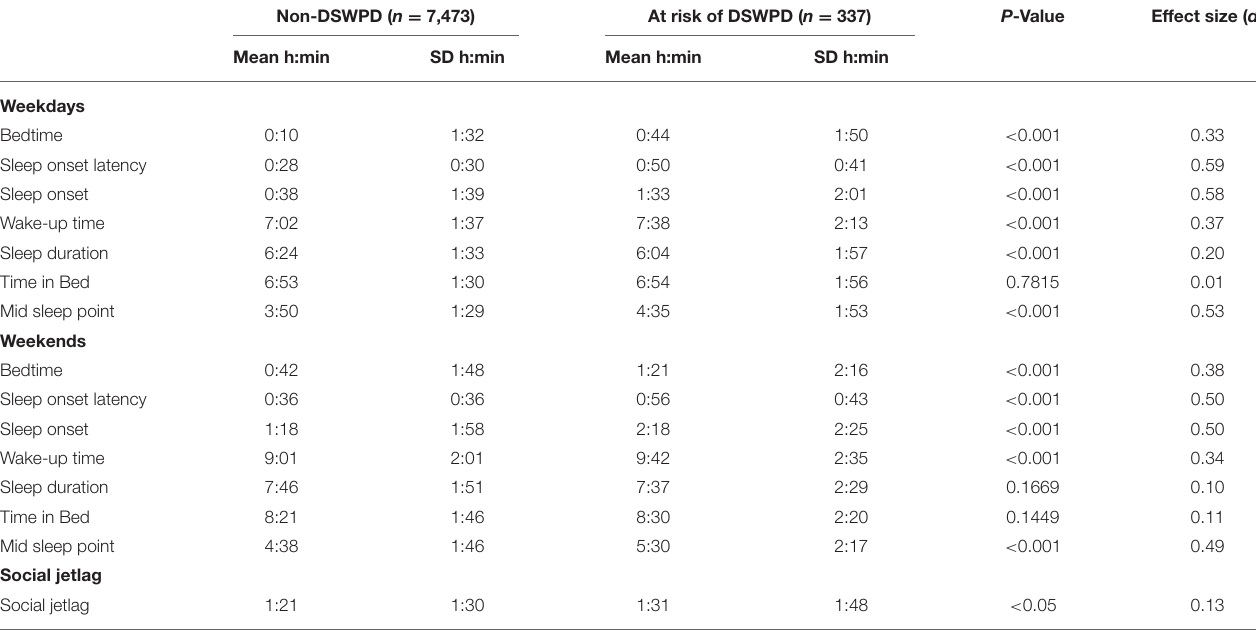
TABLE 2 | Sleep behaviors of the participants at risk of delayed sleep-wake phase disorder (DSWPD) and those who were not ( n =